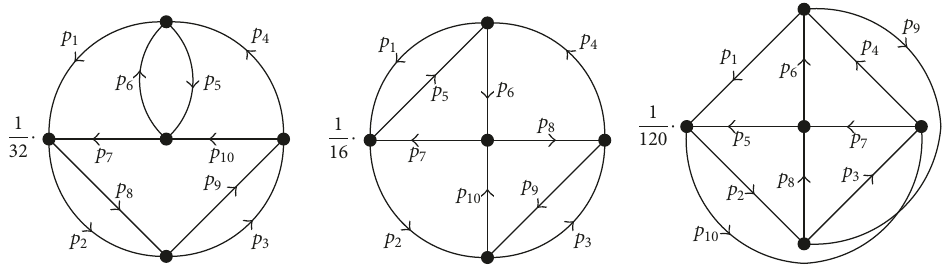
0.0031 ). This is the only nonplanar diagram up to six-loop